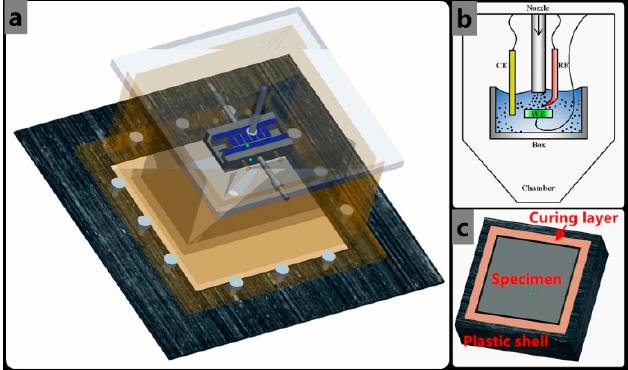
Figure 2. Schematic of the erosion–corrosion jet experimental system: ( a ) three-dimensional diagram of the test section, including the sample holder, the nozzle, and the peripheral glass shield; ( b ) installation diagram of three-electrode system; and ( c ) schematic of the sample package structure. Table 1. Chemical composition of TP140 and 13Cr steels (wt %).